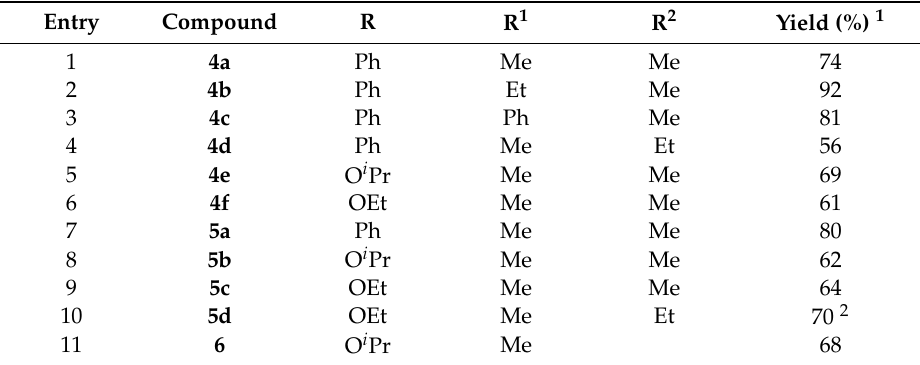
Table 1. α -Aminophosphine oxides and phosphonates 4 , 5 and 6